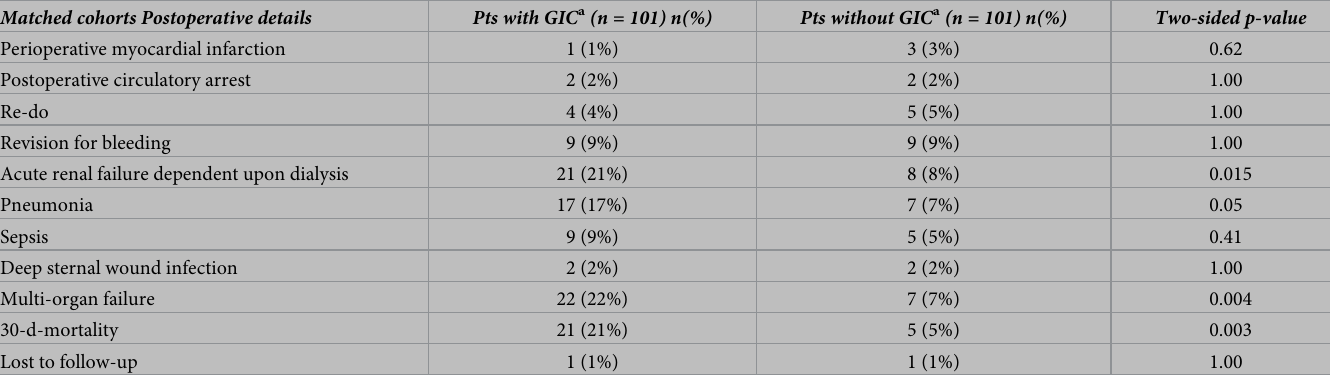
Table 6. Postoperative details (matched